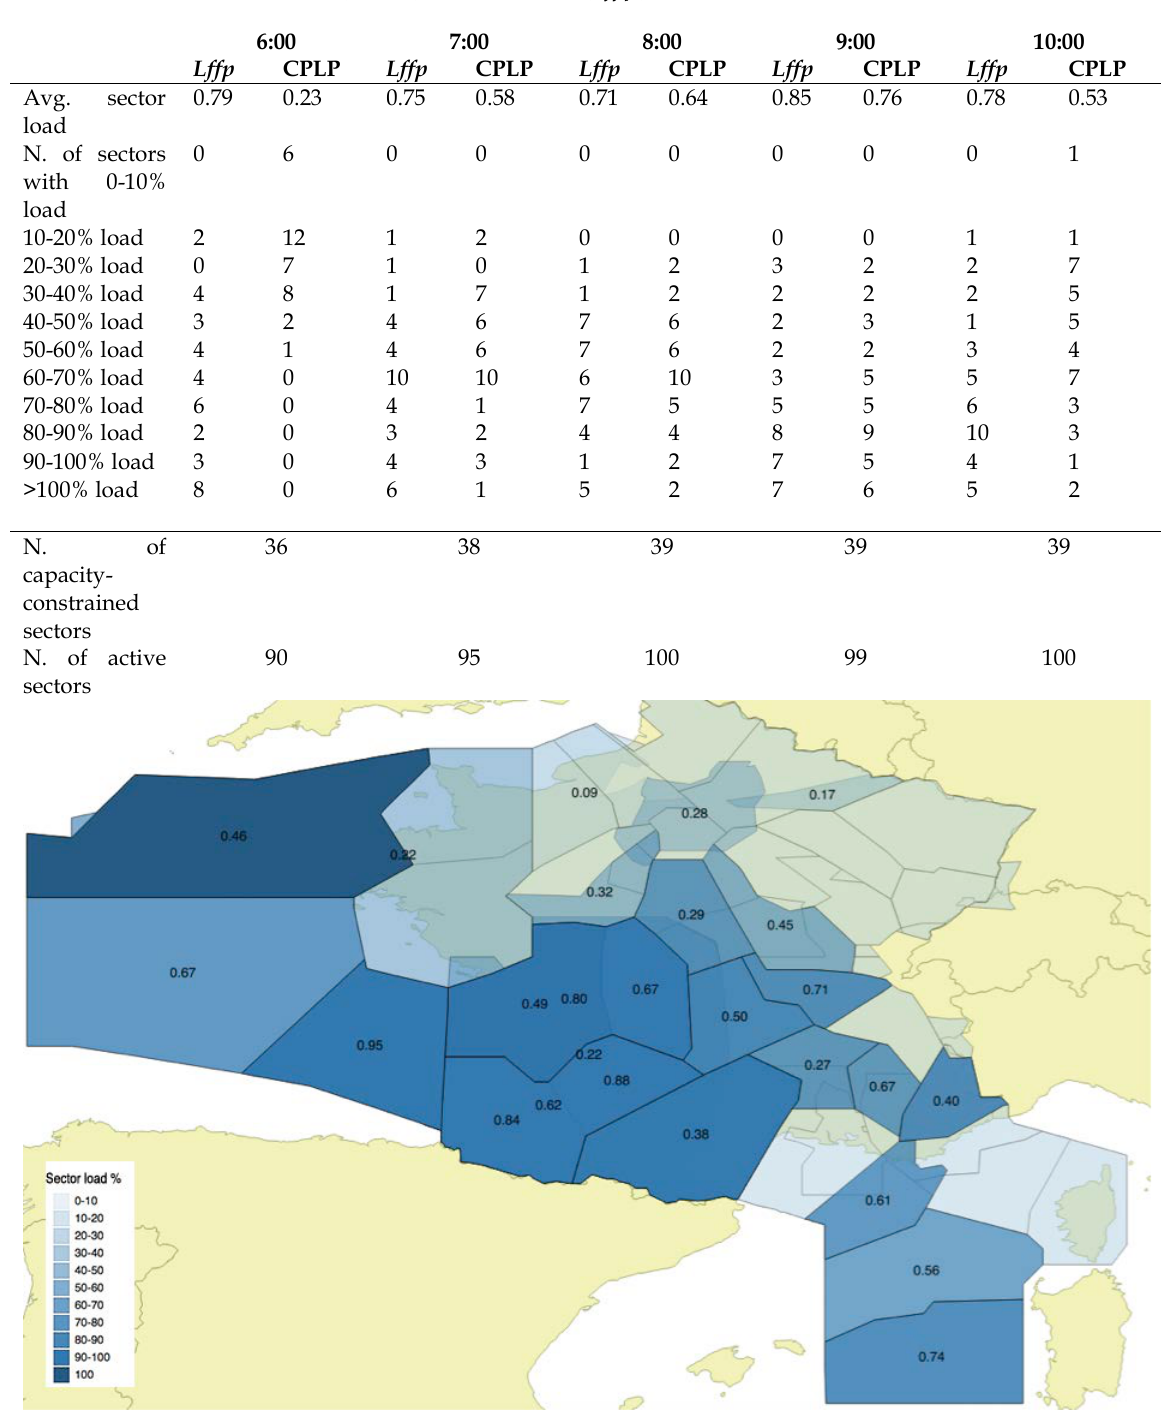
Table 3. Sector loads with (CPLP) and without ( Lffp ) unit rate modulation at different hours